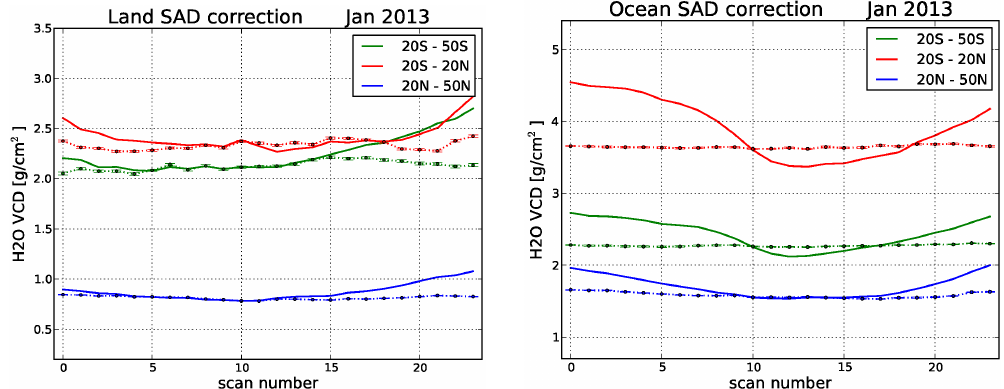
Figure 1. GOME-2A total column water vapour as a function of the number of the pixel index within the scan (0 = east, 24 = west) averaged in different latitude bands (20–50 ◦ S, 20 ◦ S–20 ◦ N, 20 ◦ –50 ◦ N) before (solid line) and after (dashed line with points) the SAD correction for January 2013. We show separately the empirical correction applied over land measurements (left panel) and over ocean measurements (right panel). The error bars represent the spread of the water vapour data points. The statistical bias as a function of the scan angle is well determined due to the large number of